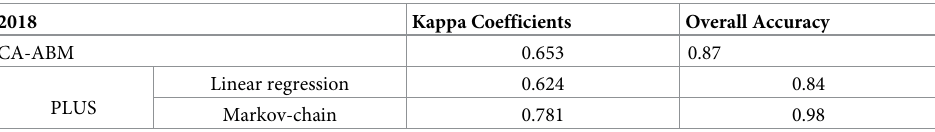
Table 4. Simulation accuracy of 2018 QPT obtained by three